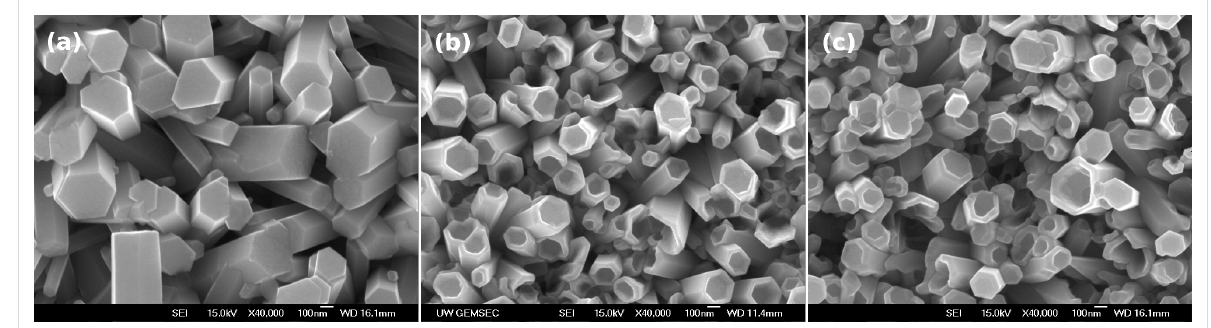
Figure 3: Evolution of the morphology of ZnO nanocrystals ranging from rods to tubes while the solution was kept at 90 °C for 3 h and then cooled down to (a) 80 °C (20 h), (b) 60 °C (20 h) and (c) 50 °C (20 h).